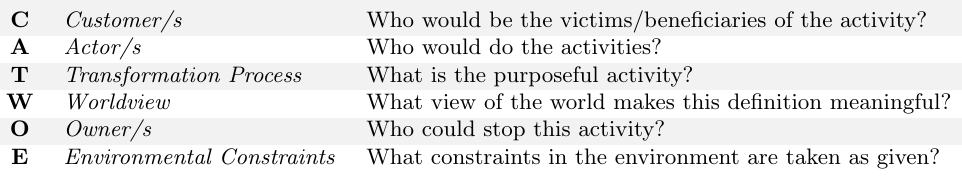
Table 1: A summary of the CATWOE